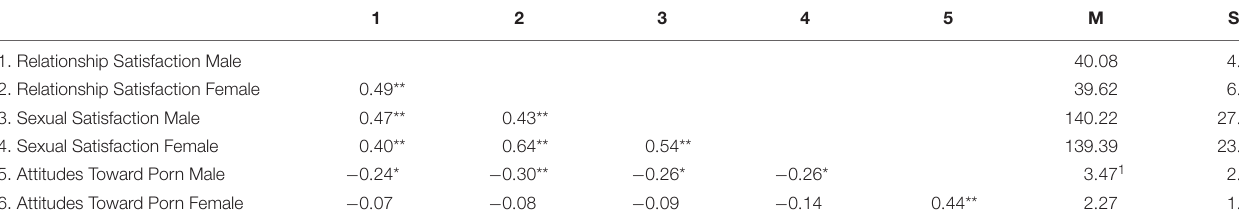
TABLE 3 | Summary of the correlations, means, and standard deviations of the focal variables for Study 2 ( N = 77 couples). 1